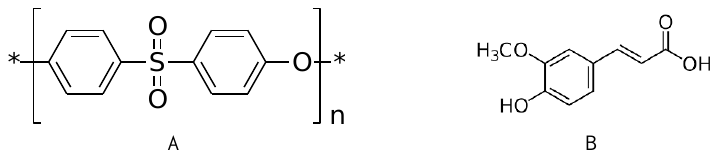
Figure 1. Molecular structure of ( A ) PES and ( B ) ferulic acid.